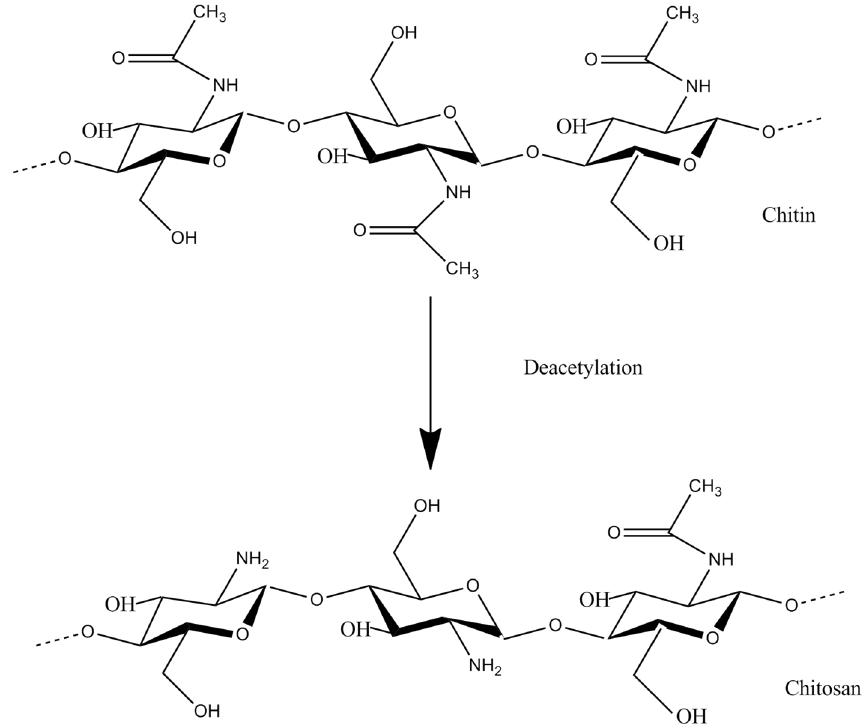
Figure 2. The chemical structure of chitin (C 8 H 15 NO 6 ) and chitosan (C 56 H 103 N 9 O 39 ).